Question: Briefly state, in one sentence, what is plotted here.
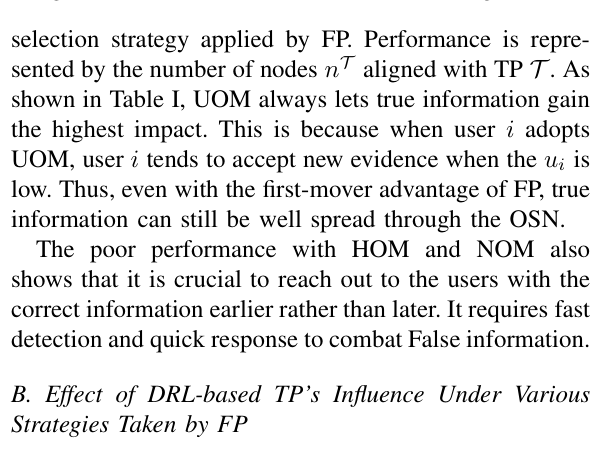
Answer: presents the comparative performance analysis of the TP’s influence under various CIM algorithms and UOM when the TP selects strategies to find seed nodes using DRL. At the same time, the FP takes the fixed strategy to select seed nodes under a fully observable network. It illustrates the effectiveness of these four CIM algorithms under UOM when the FP chooses seed nodes by a random strategy, one of four strategies in the action space, or DRL-agent. Except for Blocking First (BF, aB t ), when the FP applies the other five strategies, DRIM-A and DRIM-NA outperform C-STORM and STORM. The reason for lower performance under DRIM-A and DRIM- NA with the opponent taking BF is that blocking can mitigate the impact of opponents but is not effective in increasing its party’s influence. Therefore, our schemes are more suitable for proactive opponents. DRIM-A outperforms the DRIM-NA in most of the cases as the beneficial of Active First (AF, aAU t ) action. The gap is distinct, especially